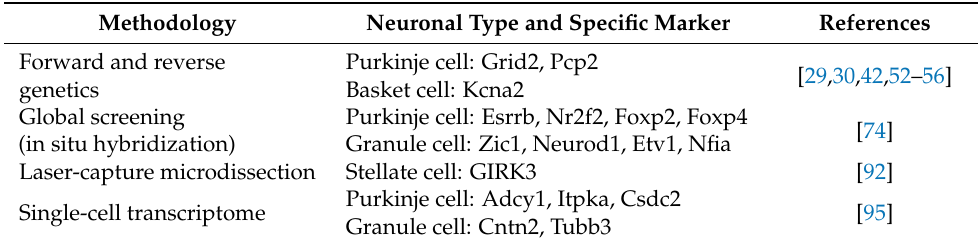
Table 1. Examples of cerebellar neuronal markers and the methodologies in which the markers were